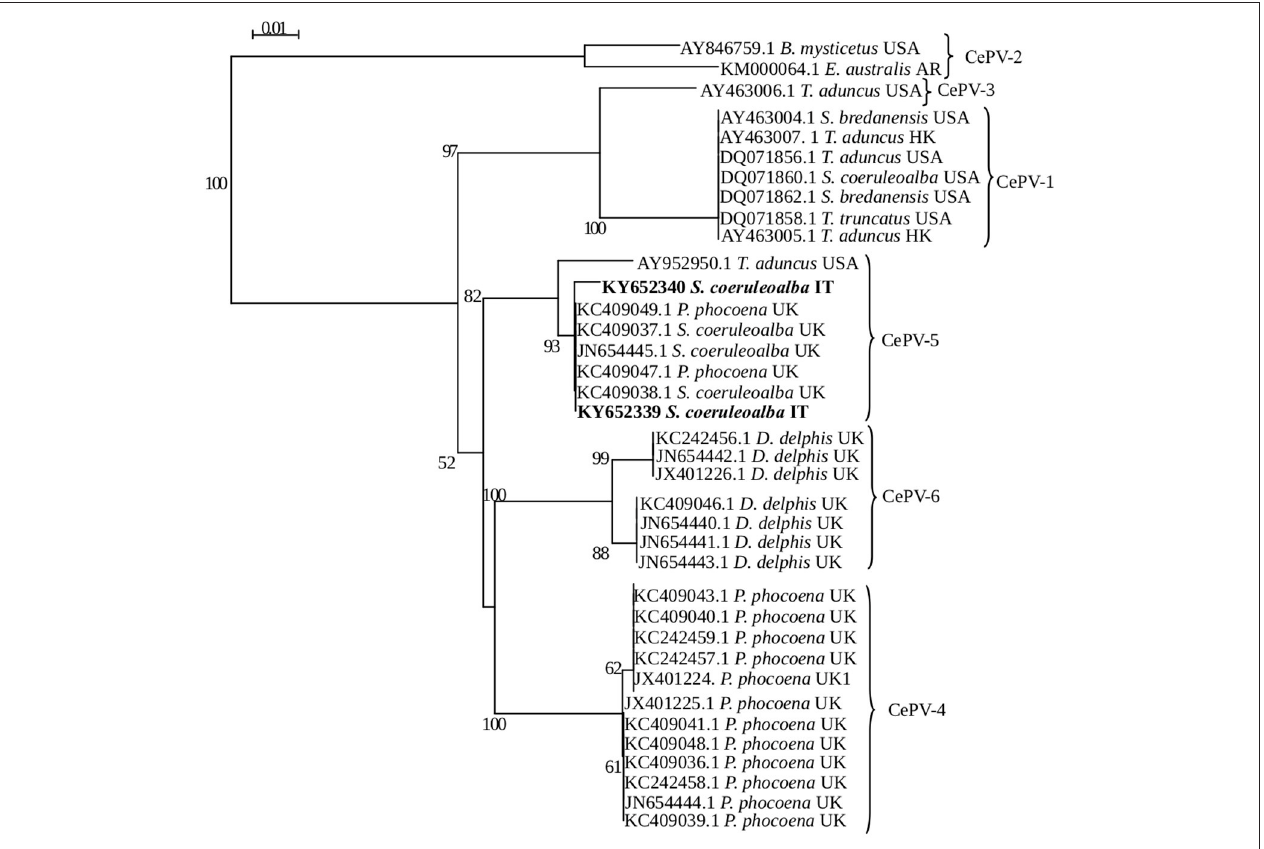
FIGURE 3 | Phylogenetic analysis of CePV polymerase gene sequences available in GenBank. Each sequence name comprises the GenBank accession number, host species and geographic origin. The groups identified by Barnett et al. ( 4) are indicated by braces. Phylogenetic trees generated with neighbor-joining method using SEAVIEW v4.2 and the confidence levels were calculated using bootstrapping (2,000 replicates). Bootstrap values under 50% were